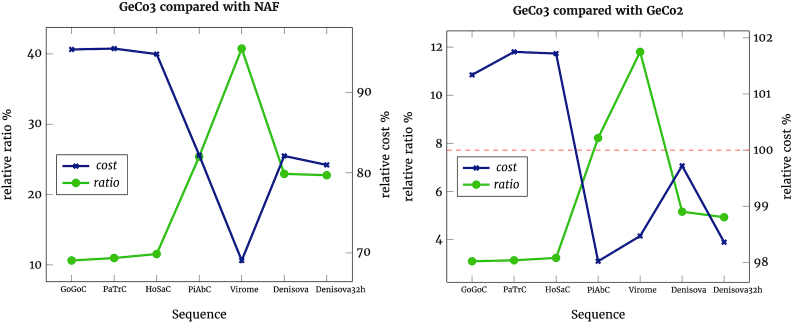
Relative ratio and cost of GeCo3 compared with NAF and GeCo2 for sequences in DS1 and DS2. Higher relative ratios represent greater compression improvements by GeCo3. The cost is calculated assuming €0.13 per GB and the storage of 3 copies. The red dashed line shows the cost threshold. Cost points above the line indicate that GeCo3 is more expensive. Denisova32h represents the results of running the Denisova sequence with 32 instead of 64 hidden nodes.